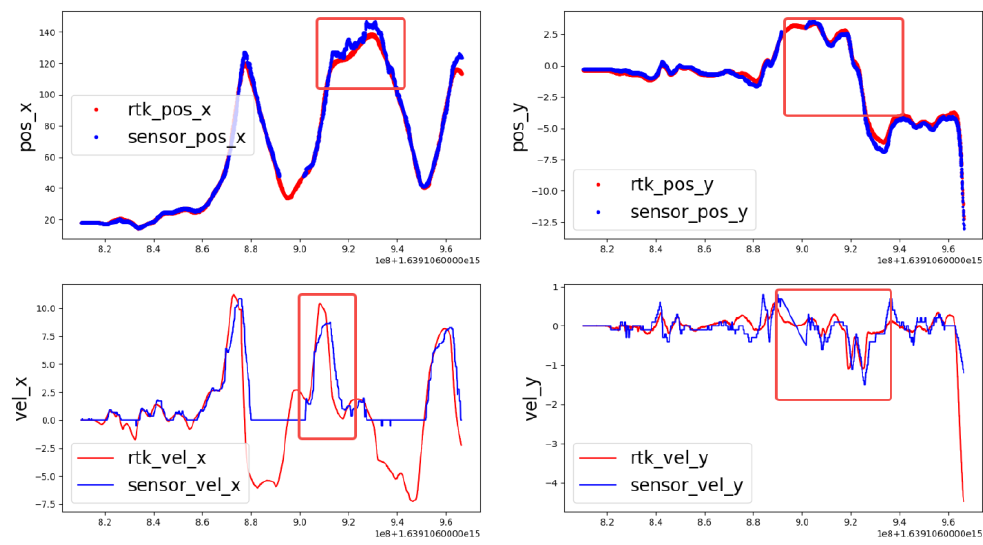
Figure 17. Tracking result between mono camera and RTK. Table 2. The statistics under the test